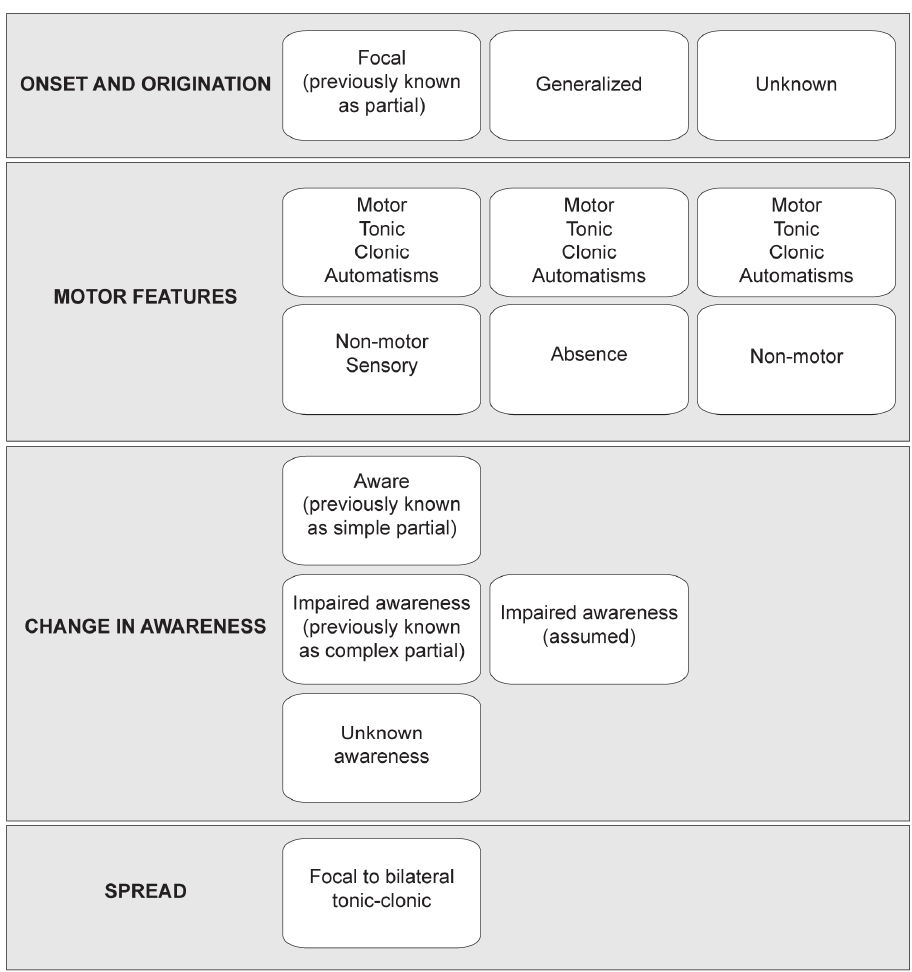
Figure 1. Classification of seizures according to the International League Against Epilepsy.